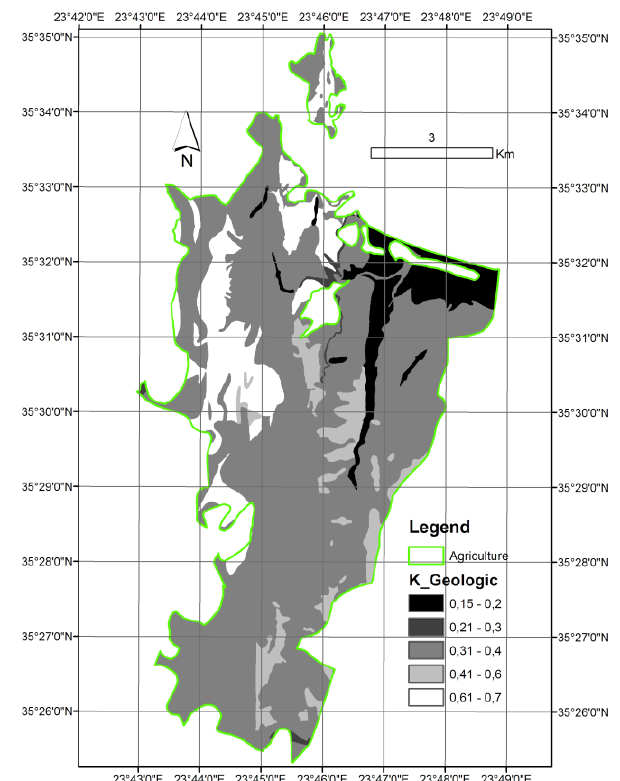
Figure 5. K-layer derived from the geologic map by